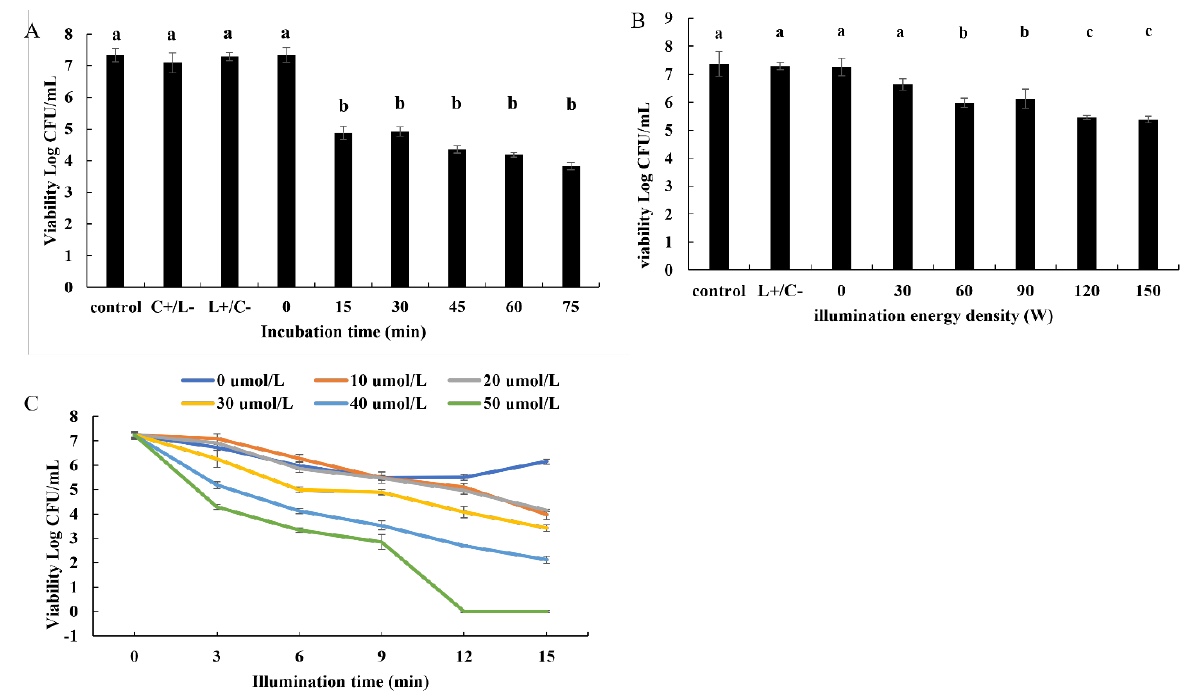
Figure 1. The viability of B. subtilis incubated with the different treatments. ( A ) B. subtilis was treated with 40 μmo l/L curcumin − mediated PDT after the incubation with curcumin for 0, 15, 30, 45, 60, 75 min in the dark. ( B ) B. subtilis was treated 40 μmol/L curcumin − mediated PDT at 0, 30, 60, 90, 120, 150 W after the incubation for 15 min in the dark. ( C ) B. subtilis was treated with 0, 10, 20, 30, 40, 50 umol/L curcumin for 0, 3, 6, 9, 12, 15 min respectively at 120 W after the incubation for 15 min in the dark. Different lowercase letters indicate the significant differences ( p < 0.05).